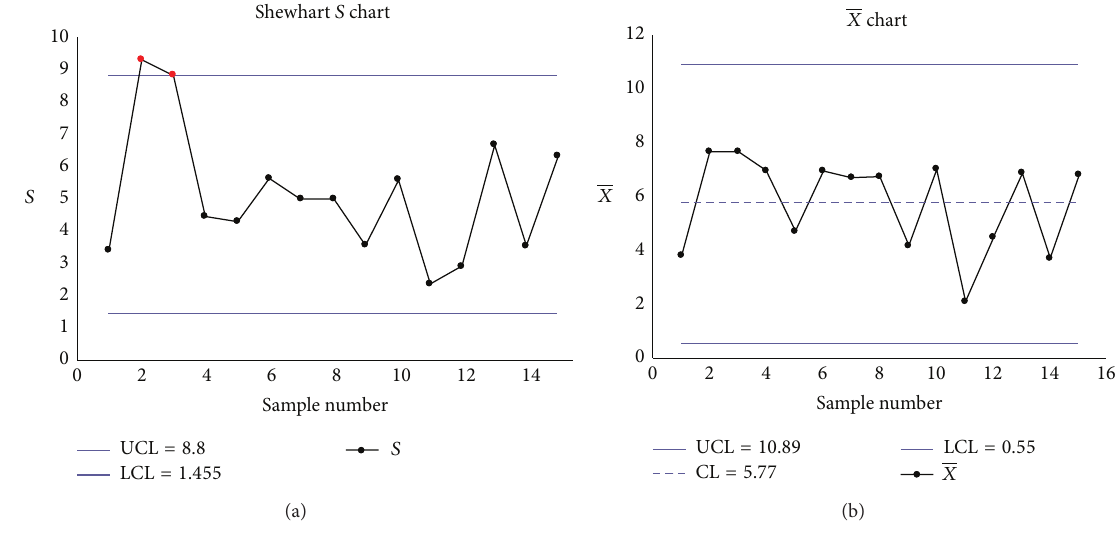
Figure 2: (a) Shewhart 𝑆 chart. (b) Shewhart 𝑋 chart.